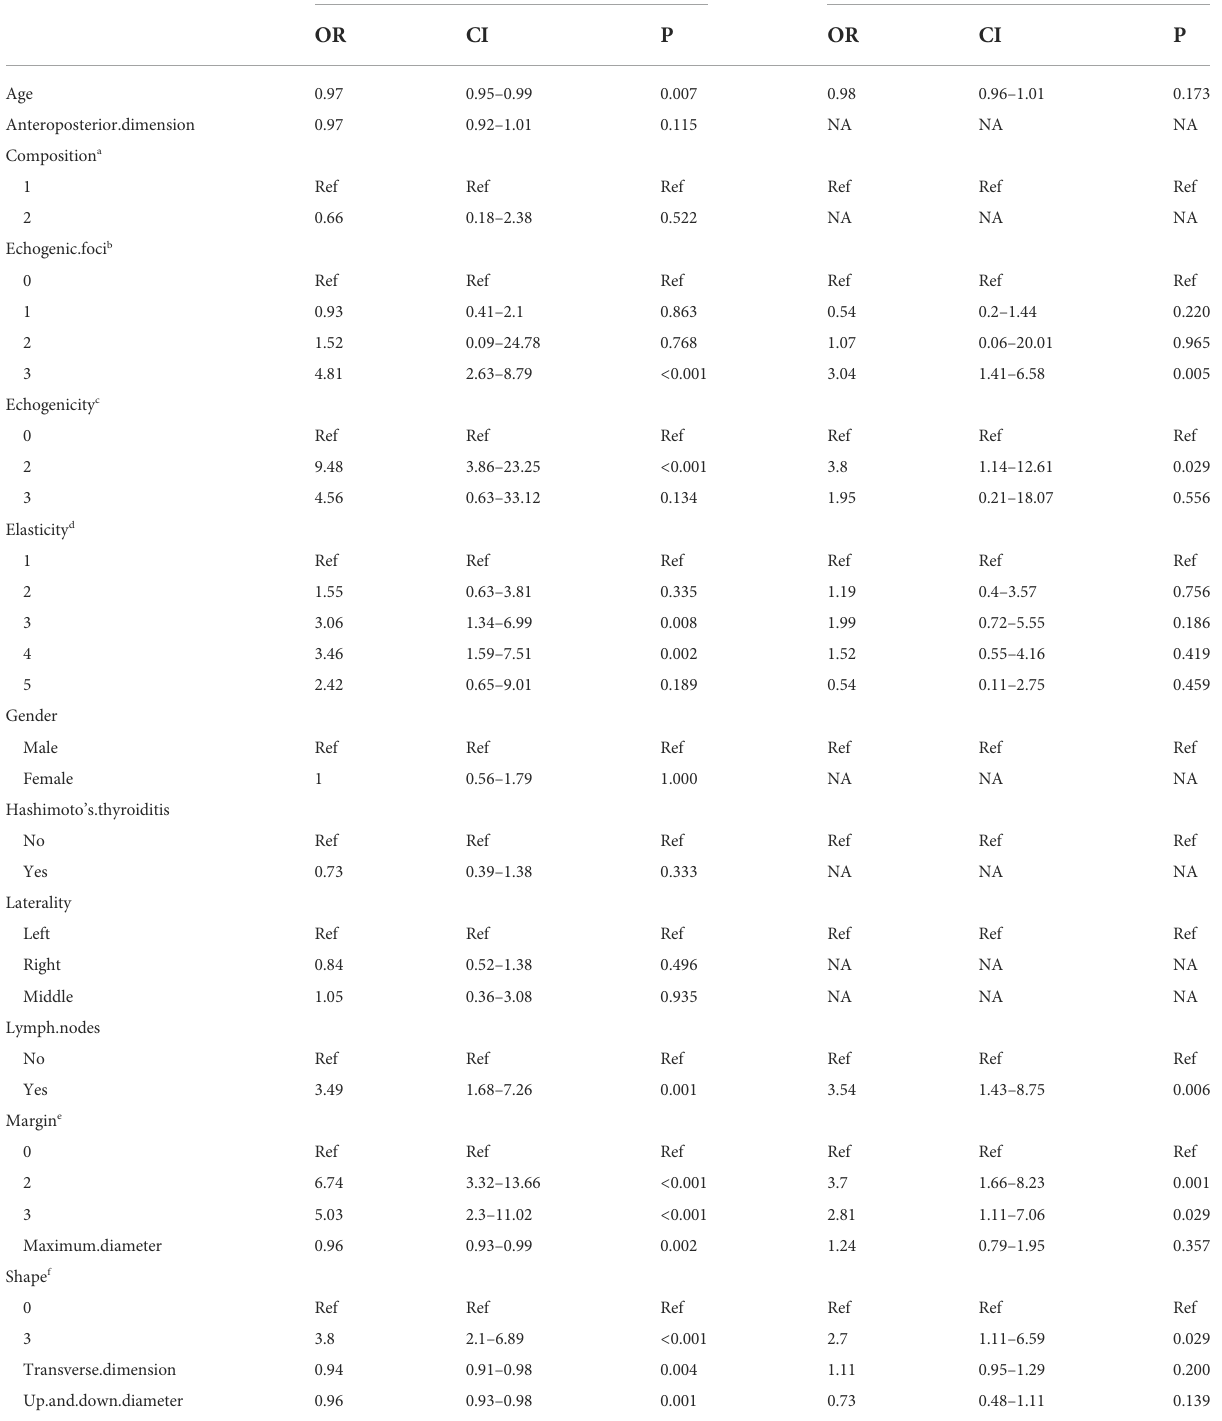
TABLE 1 Univariate and multivariable logistics regression.